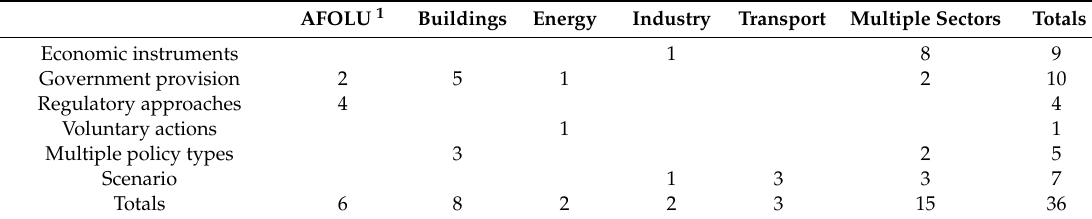
Table 2. Distribution of studies according to policy instrument and sector. AFOLU 1 Buildings Energy Industry Transport Multiple Sectors Totals Economic instruments 1 8 9 Government provision 2 5 1 2 10 Regulatory